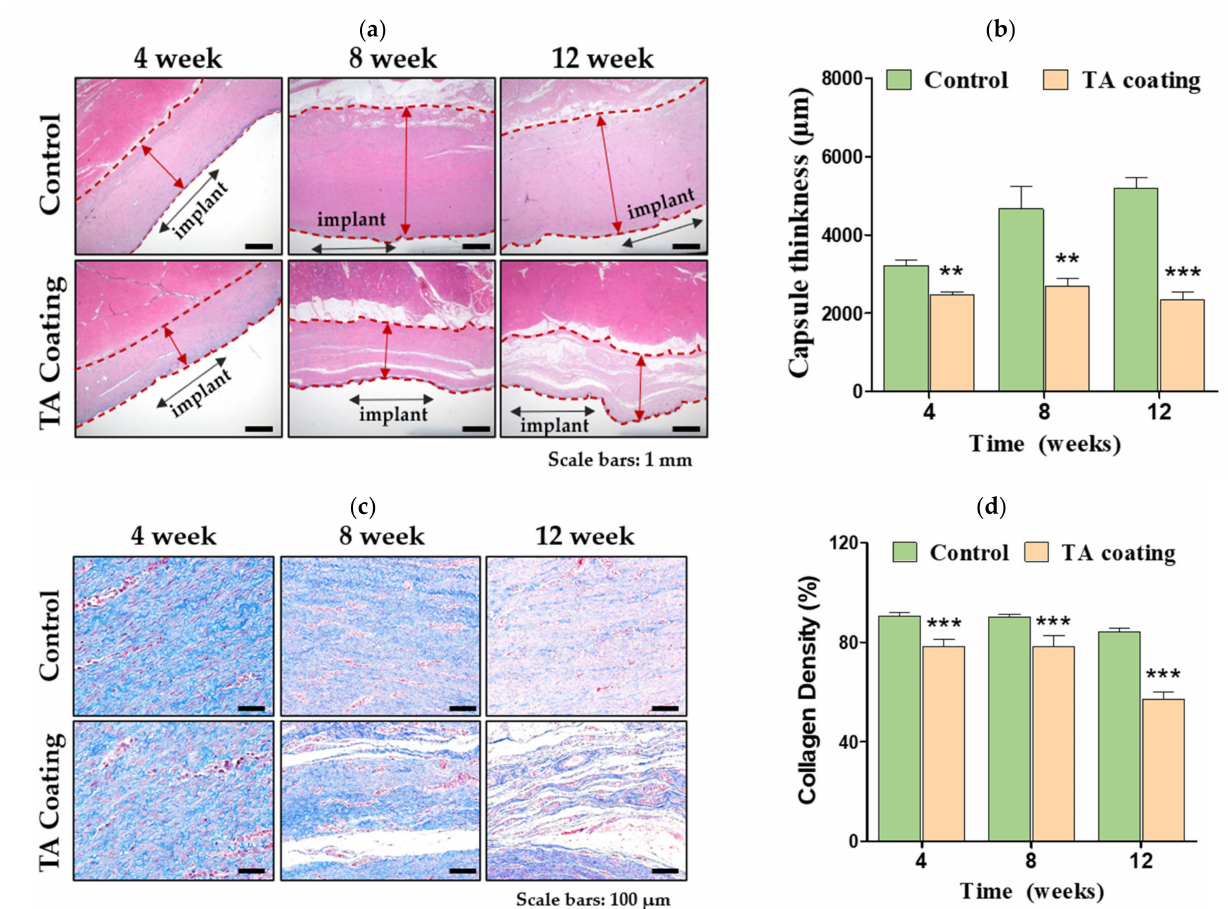
Figure 3. Histological evaluation of capsules formed around TA-coated and uncoated (i.e., control group) silicone breast implants. ( a ) H&E-stained images of tissues at four, eight, and 12 weeks; the red double arrow indicates the capsule thickness. Scale bars = 1 mm. ( b ) Profiles of thickness in TA-coated and uncoated silicone breast implants. ( c ) MT-stained tissue images around TA-coated and uncoated silicone breast implants at four, eight, and 12 weeks after implantation. Scale bars = 100 µ m. ( d ) Profiles showing the collagen density at four, eight, and 12 weeks after implantation. ** p < 0.01 and *** p < 0.001 compared with the control